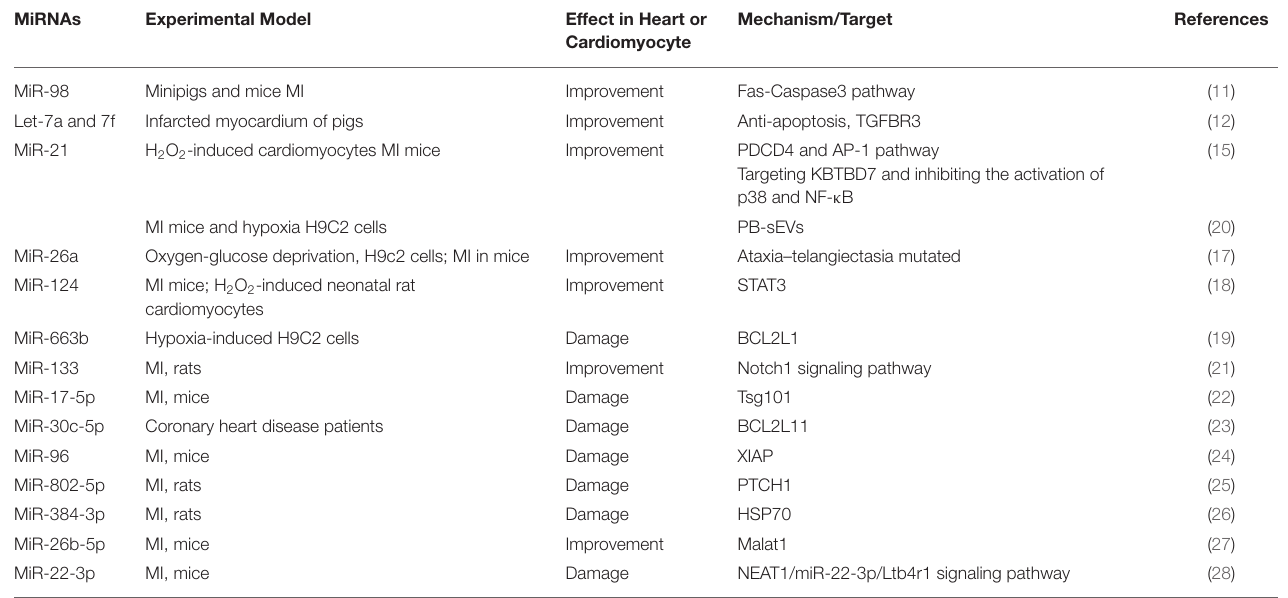
TABLE 1 | Summary of studies on miRNA regulating MI by apoptosis in the past 5 years.